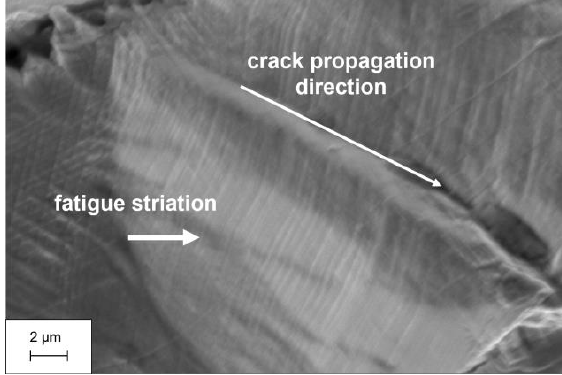
Figure 21. Characteristics of the first stage of fatigue crack growth.